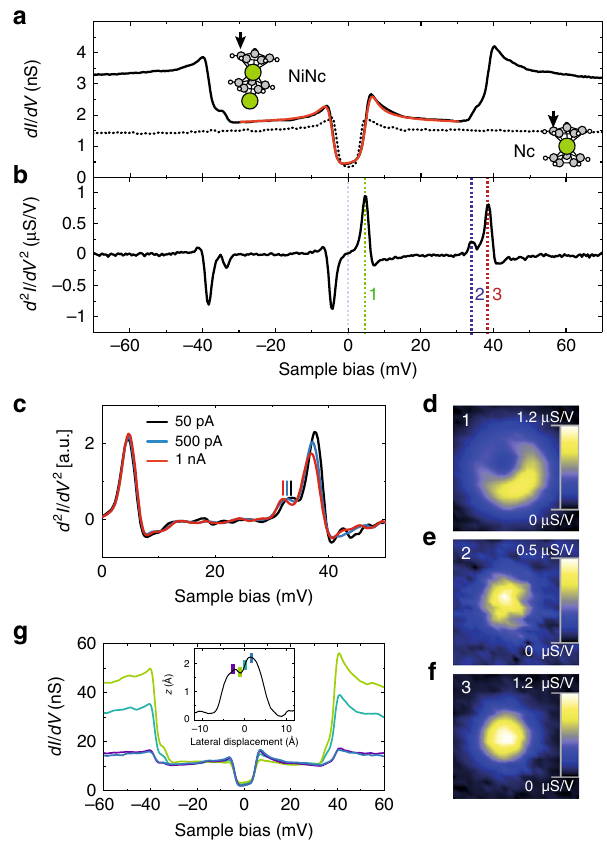
Fig. 2 Local spectroscopy of NiNc. a d I/ d V spectrum and b d 2 I/ d V 2 spectrum acquired above the Cp ring of a NiNc complex (feedback loop opened at − 80 mV and 200 pA). The solid red line is a fi t based on a dynamical scattering model 34 . The data exhibited a negligible tip dependence as re fl ected by the measurement uncertainties over a collection of NiNc complexes. The energy onsets are labeled 1 , 2 , and 3 in b . The dashed curve in a is the d I/ d V spectrum acquired above the Cp ring of a Nc in the layer (feedback loop opened at − 70 mV and 100 pA). Inset: Arrow indicates the position where the spectrum was acquired. c d 2 I /d V 2 spectra acquired above the center of a NiNc complex at various tip- molecule distances. The feedback loop was opened at 50 pA (solid black line), 500 pA (solid blue line) and 1 nA (solid red line) with a bias set to − 20 mV — higher opening currents correspond to smaller tip-molecule distances. The spectra were normalized by the opening current. The vertical lines indicate the peak position of excitation 2 . d – f Spatial variation of the d 2 I ∕ d V 2 signal acquired at a constant-height and at a bias of 4.5 mV, 32.5 mV, and 37 mV, respectively (feedback loop opened at − 60 mV and 500 pA above a Nc molecule of the layer; 3 mV rms modulation amplitude). These biases correspond to the excitation thresholds highlighted in b . g d I / d V spectra acquired at four locations above NiNc [indicated by colored dots in the line pro fi le of NiNc presented in the inset]. The feedback loop was opened at − 30 mV (300 pA) above all locations in order to have the same amplitude for step 1 in the d I ∕ d V